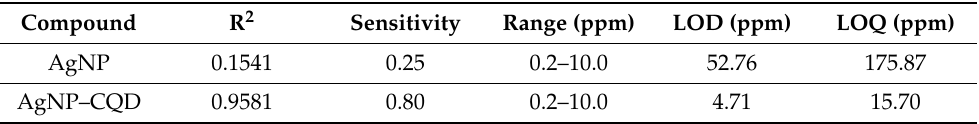
Figure 9. The LSPR calibration curve of bare AgNPs (red) and a AgNP–CQD composite (black) detects chlorophyll ranging from 0.2 to 10 ppm concentration. Table 1. The performance and correlation coefficient R 2 of AgNPs and a AgNP–CQD composite for chlorophyll detection.